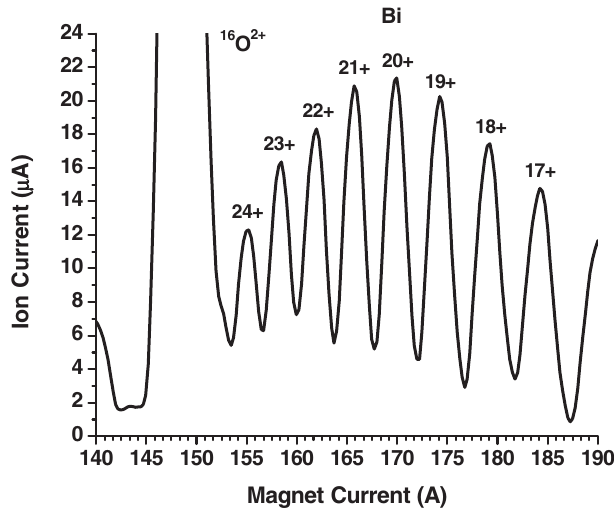
FIG. 2. Bismuth beam intensities for different charge states measured at 90 kV.